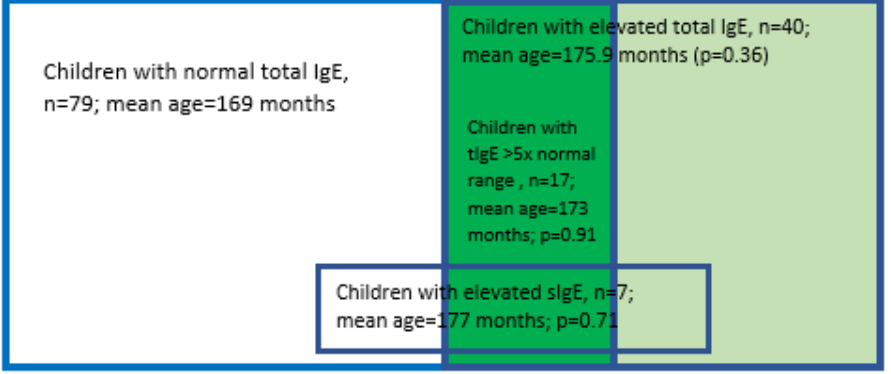
Figure 1. CD population structure.